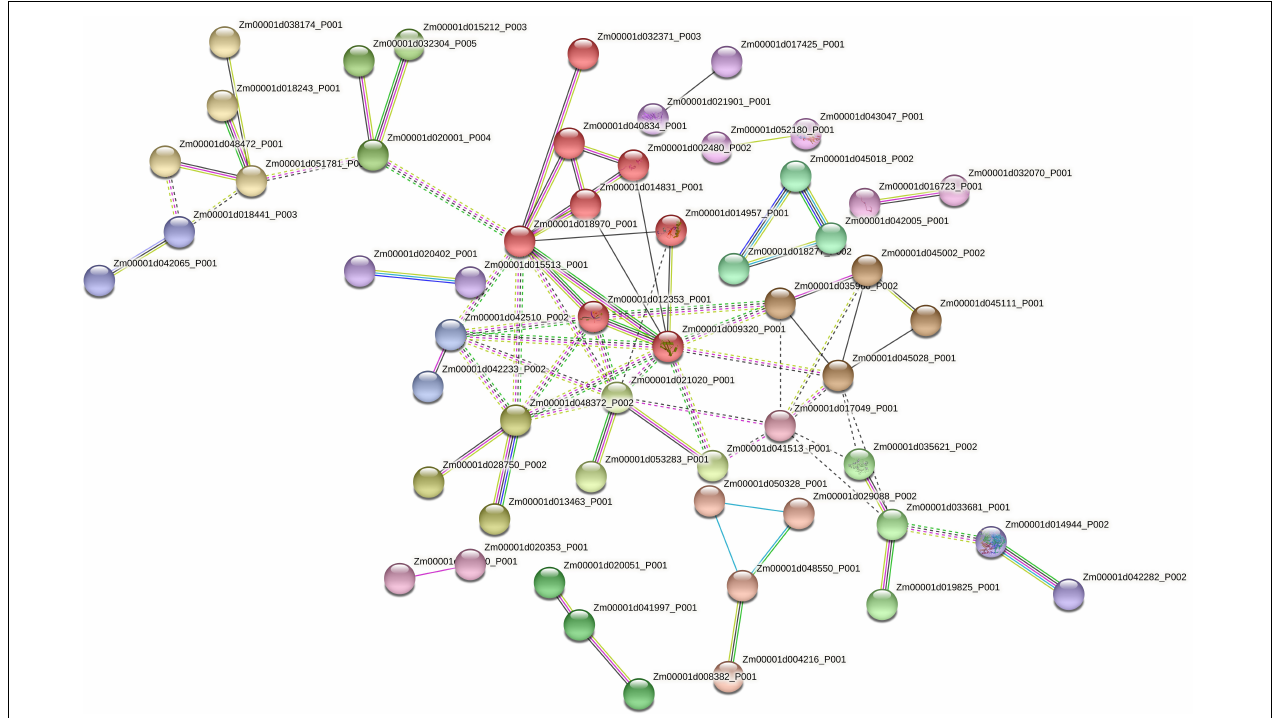
FIGURE 3 | High-confidence protein–protein interaction networks (interaction score > 0.7) among DEGs using the online search tool STRING for the retrieval of interacting genes (https://string-db.org/) (Version 11.0) (Szklarczyk et al.,